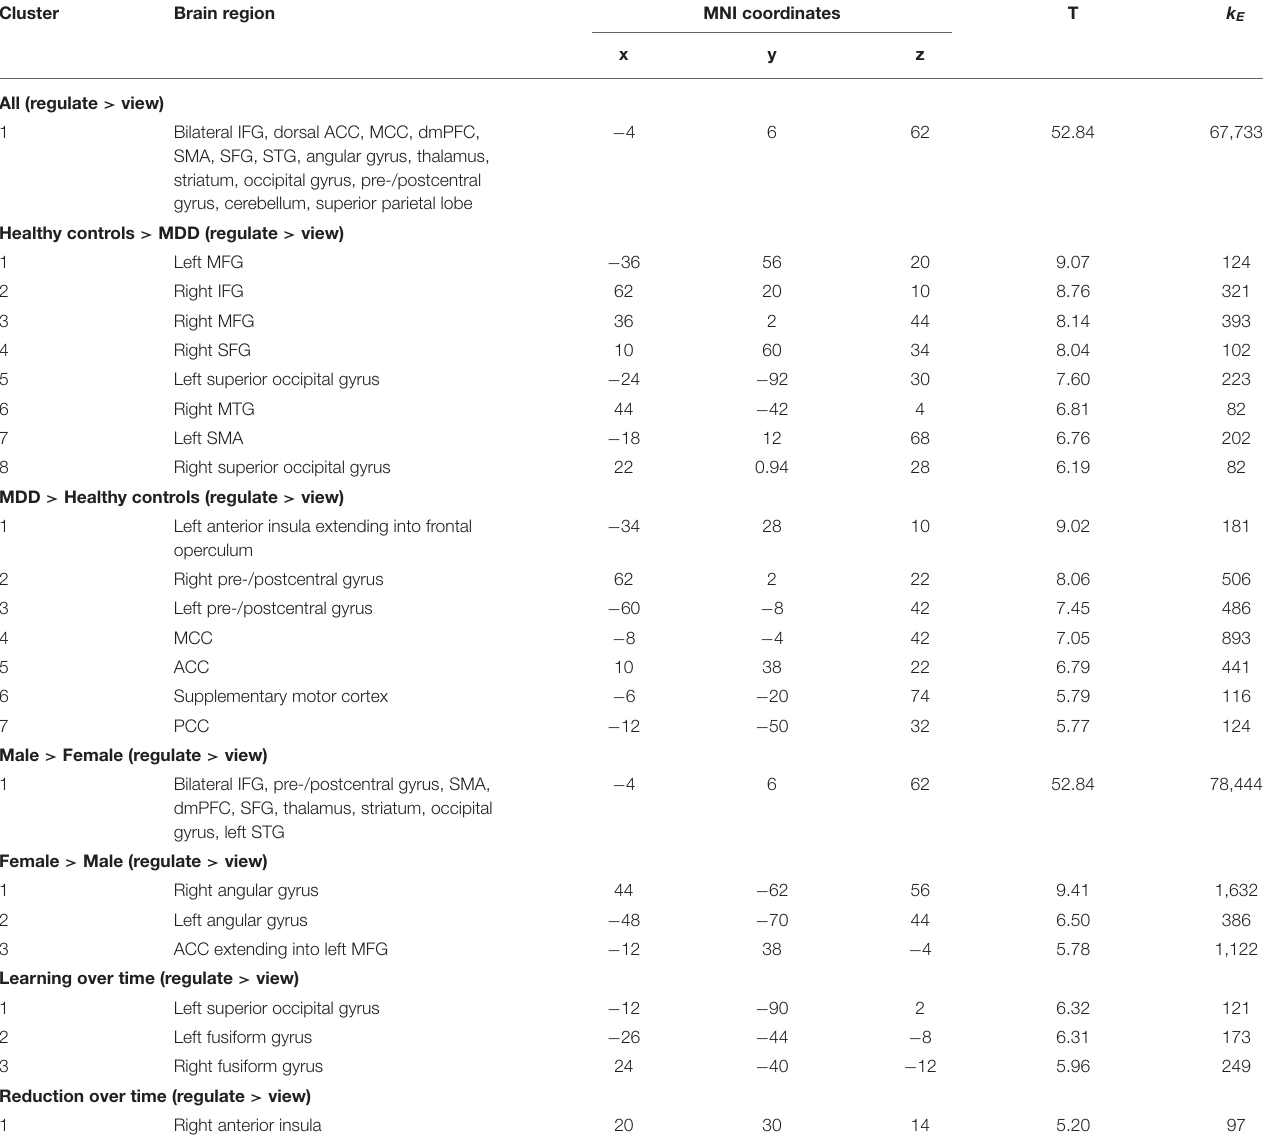
TABLE 3 | Activation peaks associated with NF-guided cognitive reappraisal. Cluster Brain region MNI coordinates T k